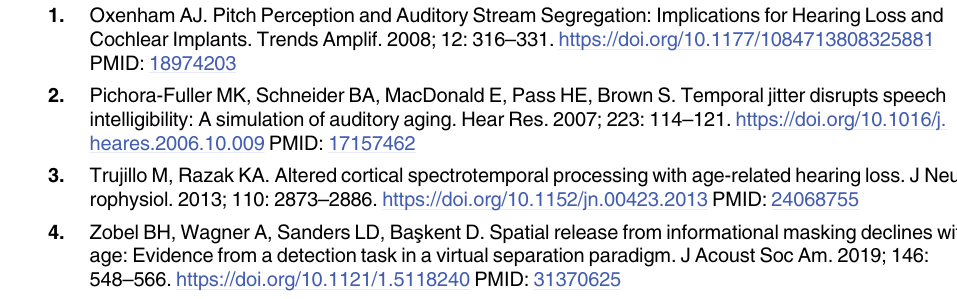
S1 Table. Thresholds per trial. Thresholds of enhanced-to-SSN SNR for each of our 31 sub- jects across 12 trials– 4 trials per